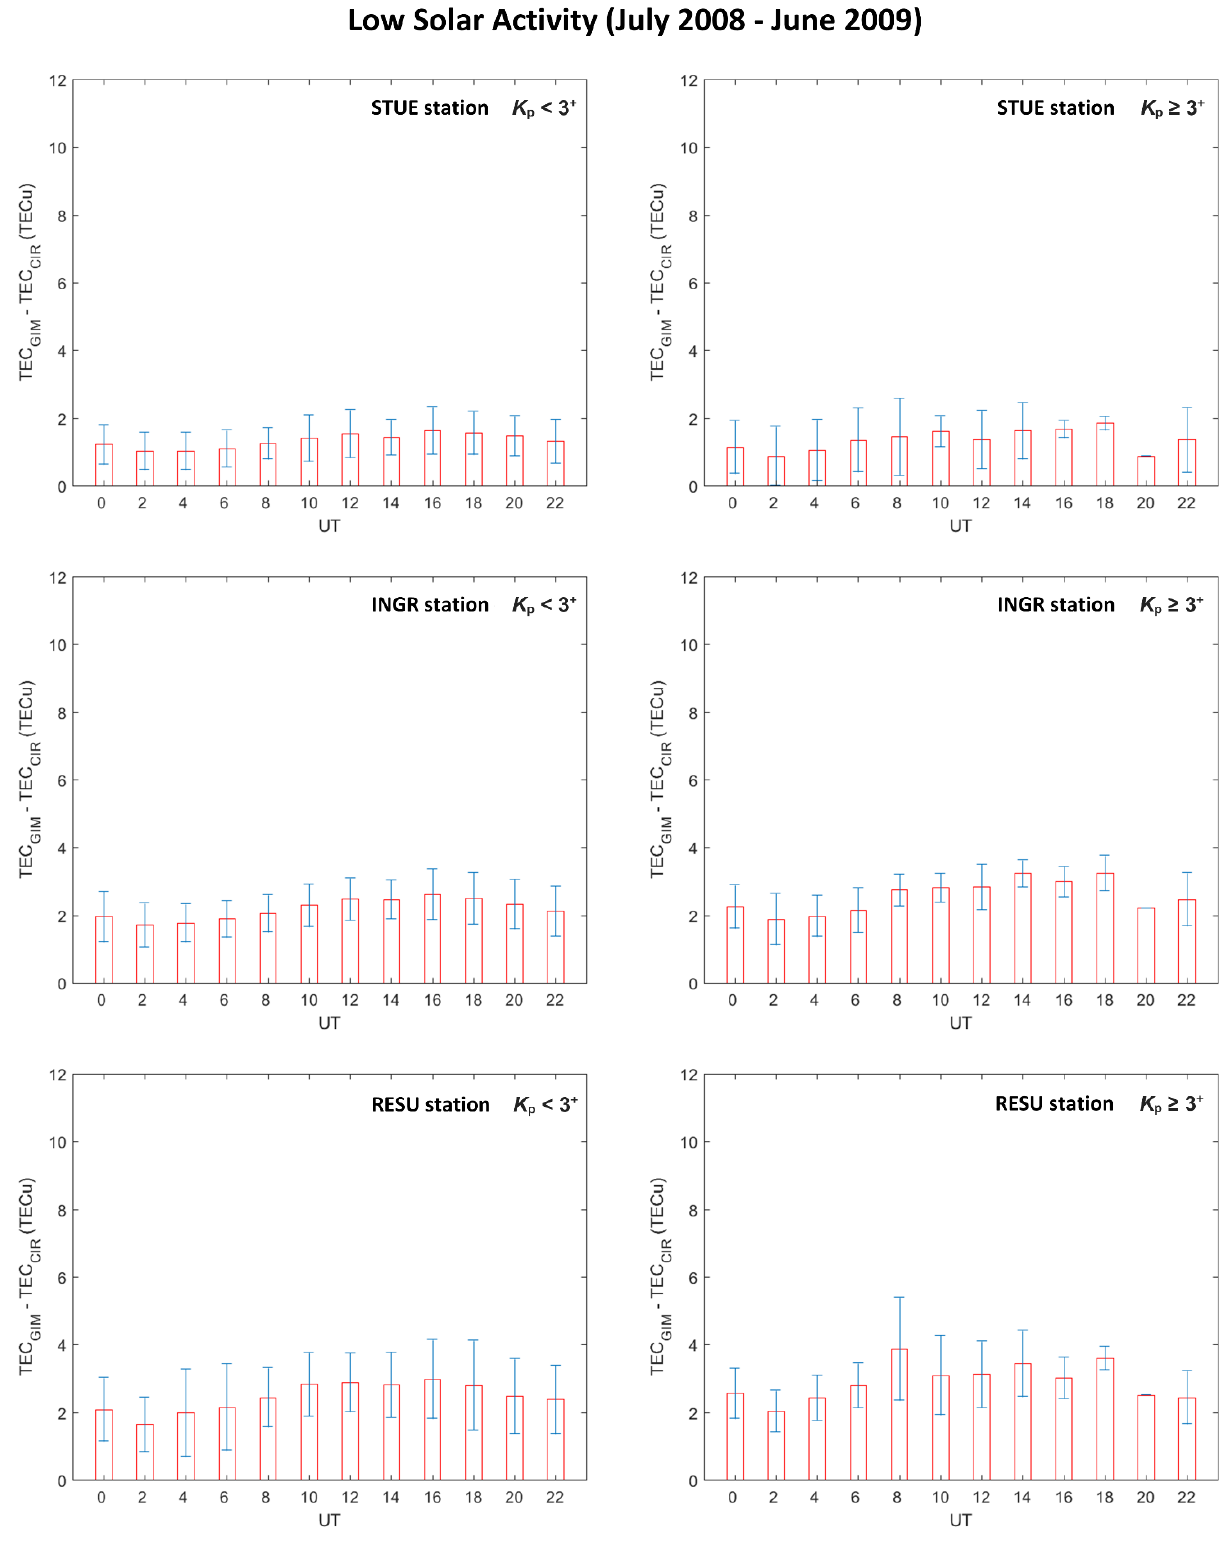
Figure 5. Daily variation of the difference (TEC GIM - TEC CIR ) in terms of hourly mean and corresponding standard deviation, with a time resolution of 2 h (corresponding with the time resolution of GIMs), for STUE (upper row), INGR (middle row) and RESU (lower row) for the LSA period between July 2008 and June 2009. Left panels refer to quiet geomagnetic values ( K p < 3 + ), while right panels refer to disturbed geomagnetic values ( K p ≥ 3 + ).